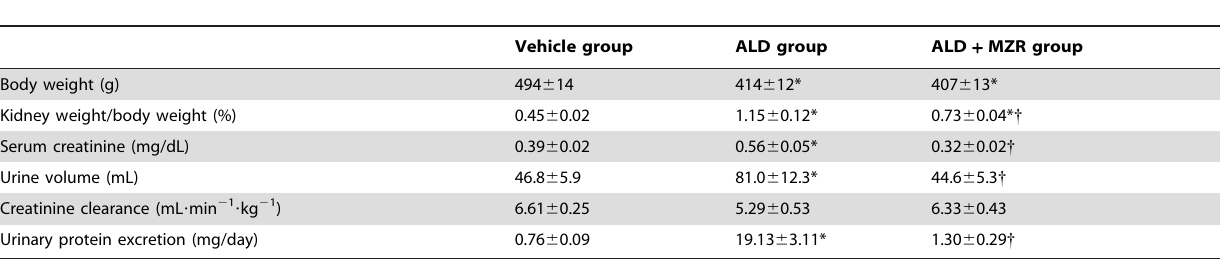
Table 2. Data for the three groups at the end of the 6-week experiment.